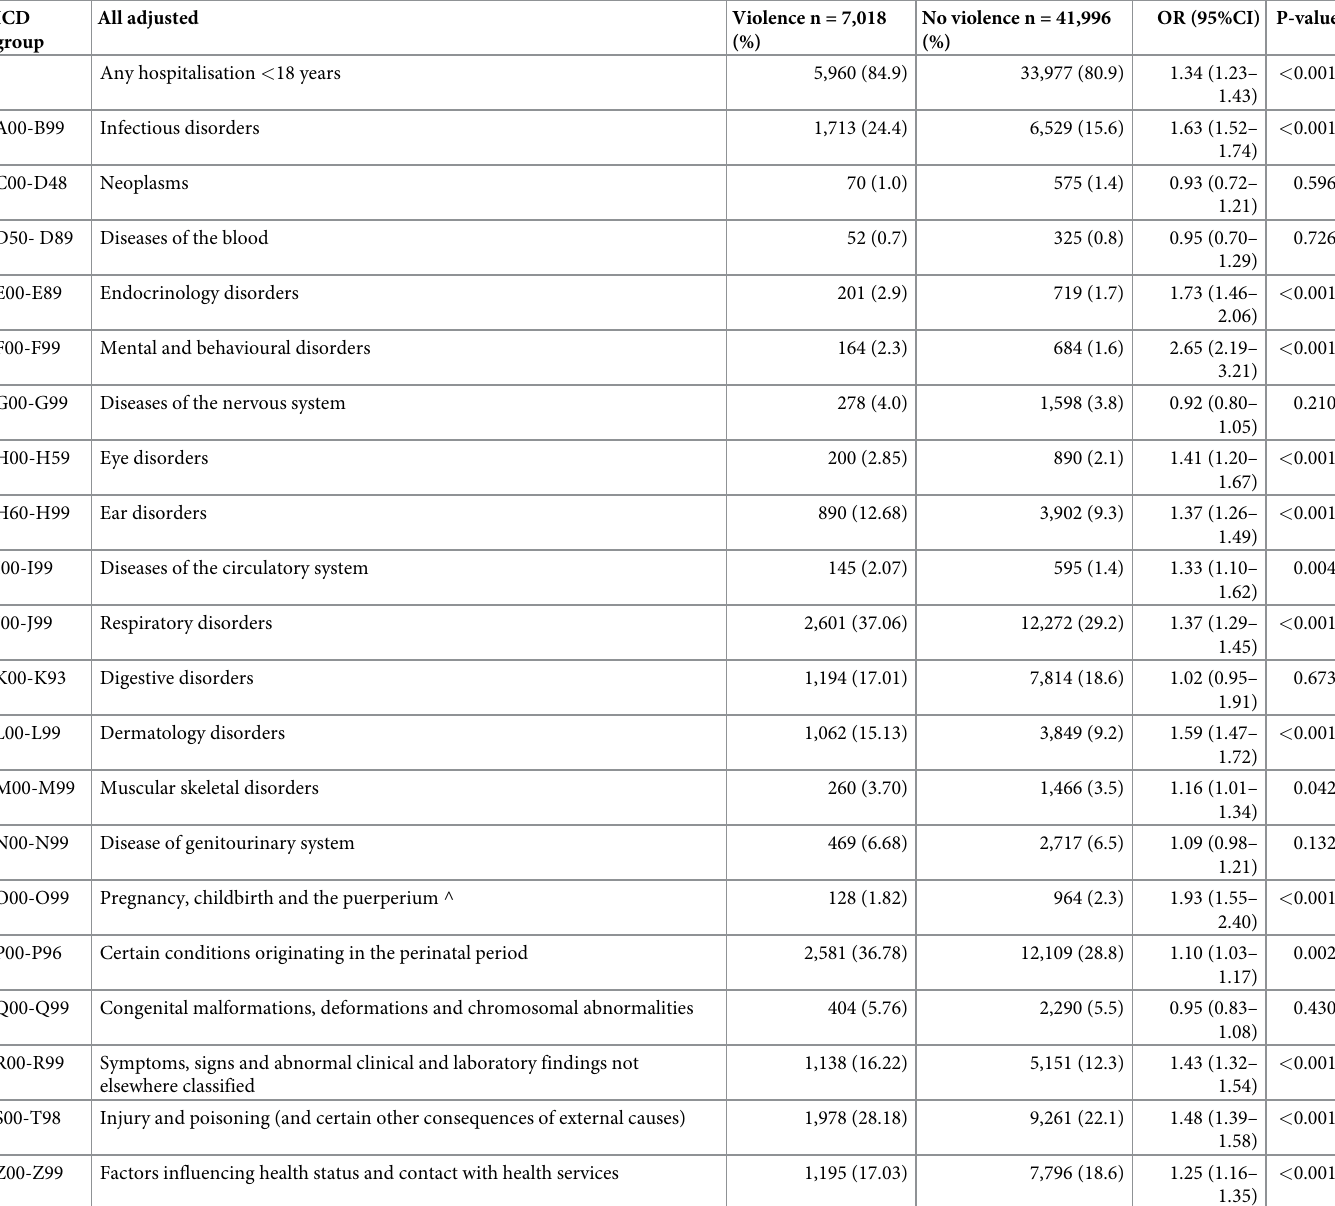
Table 3. Adjusted � principal hospitalisations for children exposed and non-exposed to FDV in early childhood